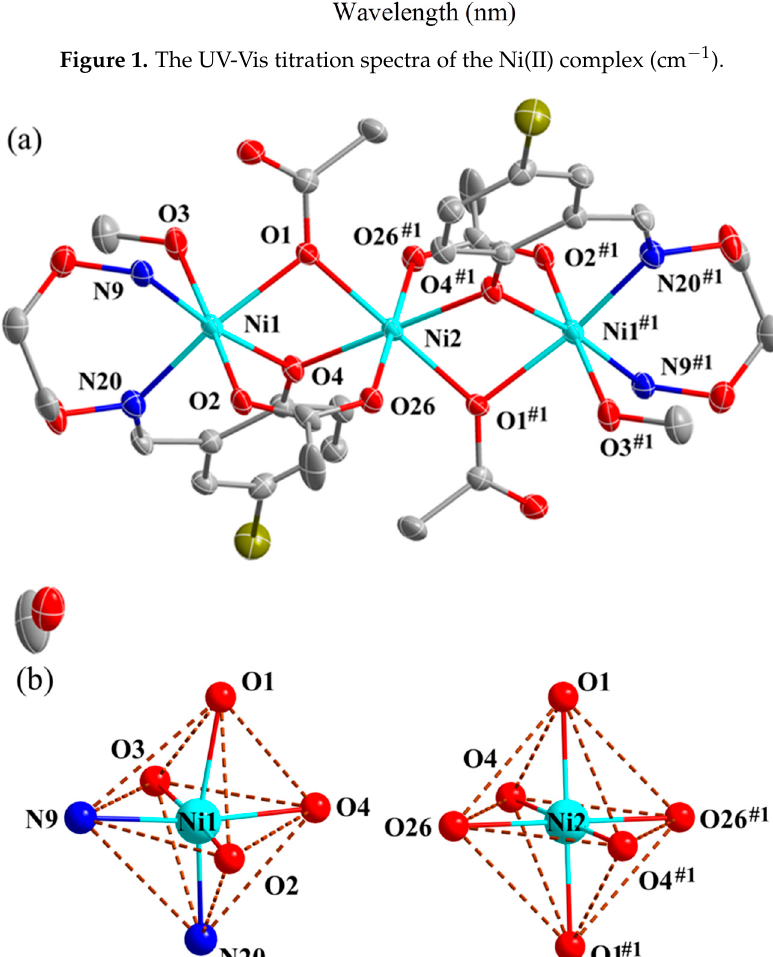
Figure 2. ( a ) Molecular structure of the Ni(II) complex with 30% probability displacement ellipsoids (hydrogen atoms are omitted for clarity); ( b ) coordination polyhedrons for Ni(II) atoms. Table 3. Bond lengths (Å) and angles (°) of the Ni(II) complex.